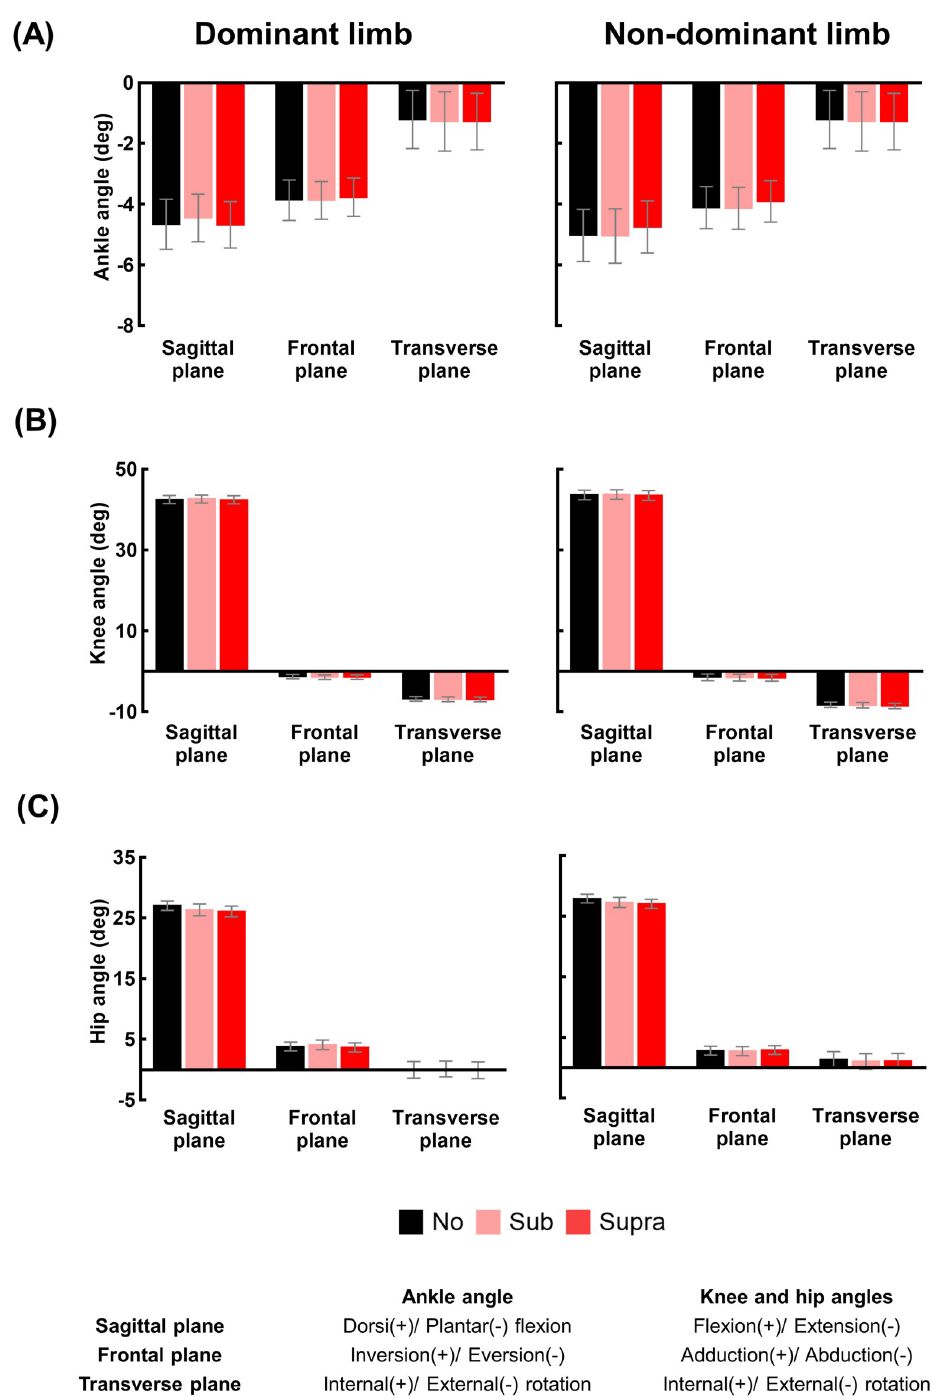
Fig 4. Changes in the lower limb joint angles at MTC due to vibrations. (A-C) show the means and standard errors of the ankle, knee, and hip angles at MTC of 17 participants, respectively, for the three vibration levels (No: no vibration, Sub: sub-threshold vibration, and Supra: supra-threshold vibration) and both feet.